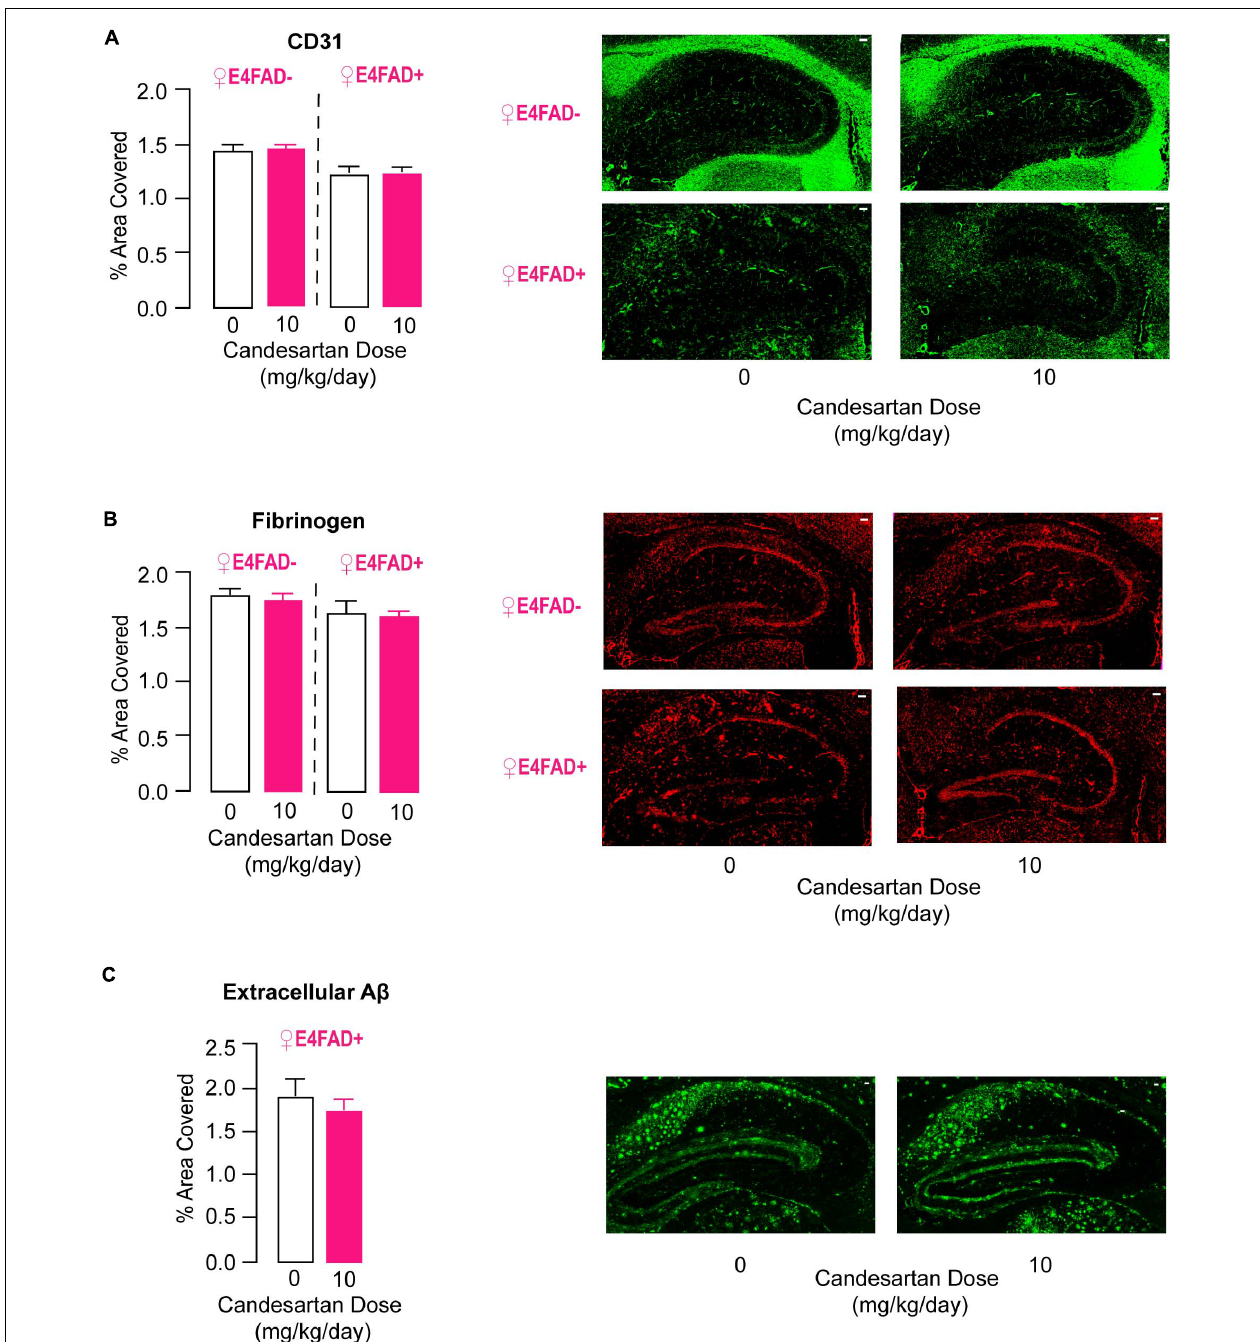
FIGURE 5 | High-dose candesartan treatment did not alter makers of cerebrovascular dysfunction or levels of extracellular A β compared to vehicle treatment in female E4FAD − and E4FAD + mice. In female E4FAD − and E4FAD + mice treated with 10 mg/kg/day (high dose) candesartan there were no differences in hippocampal area immunostained with (A) CD31 [E4FAD − : t (16) = 0.28, p = 0.78. E4FAD + : t (18) = 0.003, p = 0.99], (B) fibrinogen [E4FAD − : t (15) = 0.47, p = 0.64. E4FAD + : t (14) = 0.23, p = 0.82], or (C) A β [MOAB2 antibody, t (18) = 0.74, p = 0.47] compared to vehicle when assessed by quantitative IHC analysis. All data expressed as mean + / − SEM. p > 0.05 by Student’s t -test. Scale bars = 100 µ m. See Supplementary Table 2 for details on n sizes.